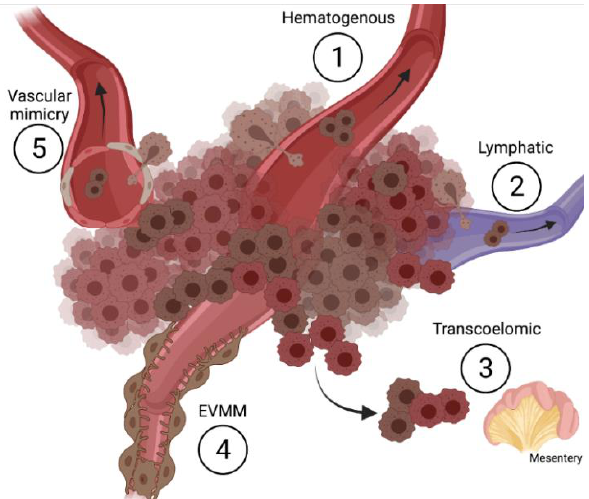
Figure 1. Schematic representation of metastatic routes (created with BioRender.com).